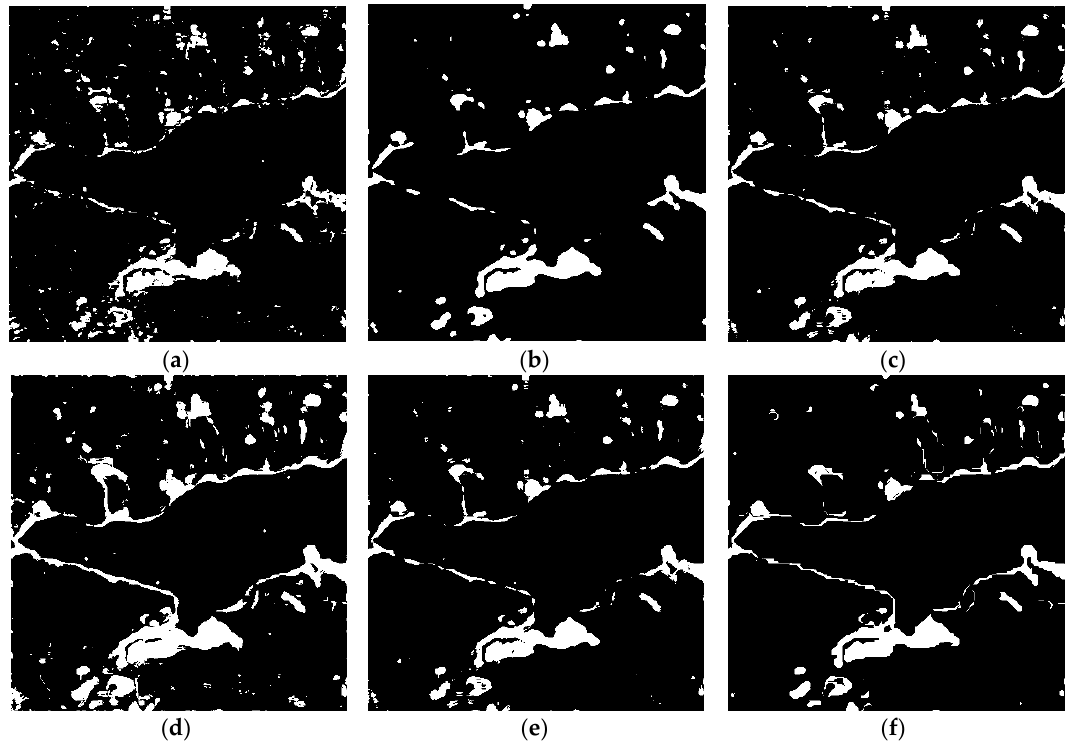
Figure 8. Change detection results of the different algorithms over LiangZi Lake between 2011 and 2016. ( a ) Change detection result using OT_GGMM_pix ( k = 18). ( b ) Change detection result using